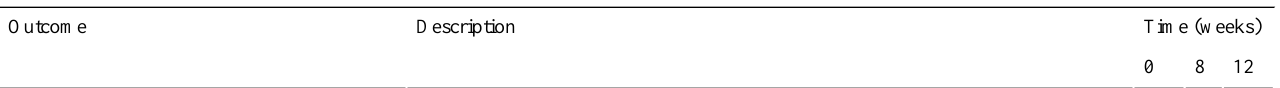
Table 3. For specific aim 2, study outcomes will be assessed pretreatment (week 0 at evaluation session 1), after completion of education combined with exercise (week 8 at evaluation session 2), and after 4 weeks of continuing the home exercise program at home (week 12 at evaluation session